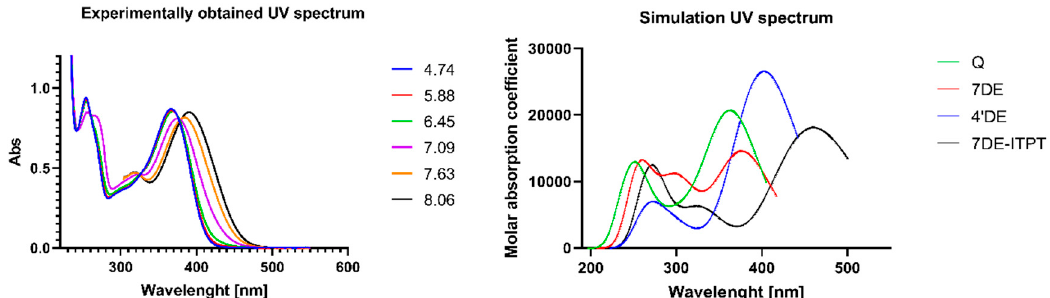
Figure 2. The experimentally obtained UV spectrum of a Q solution (50 µ M) in a 50 mM phosphate buffer at various pH values ( left panel) and the simulated UV spectra ( right panel) of Q and the three energetically most favorable mono-deprotonated forms of Q. i.e 7-OH deprotonated Q (7DE), 4 ′ -OH deprotonated Q (4 ′ DE) and the tautomer of 7DE in which the proton of the 3-OH group is transferred to the 4 oxygen atom (7DE-ITPT).